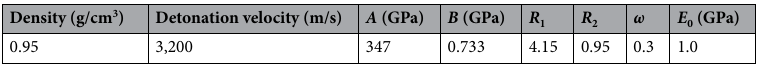
Table 3. Explosive parameter settings used in the numerical model.